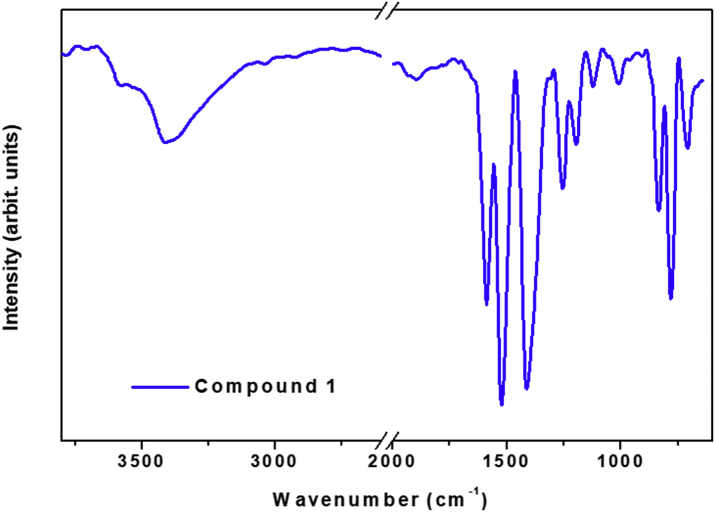
Infrared spectrum for [La(4-OHBBA)3(H2O)2] compound.